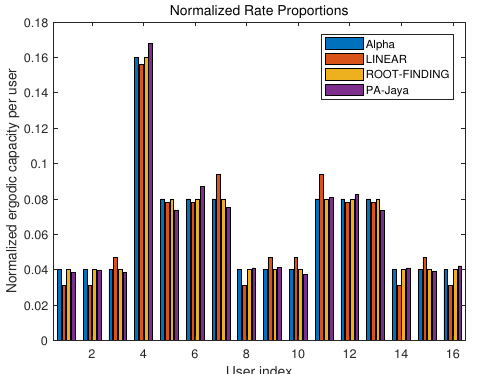
Figure 7. Comparison of different algorithm effects under normalized rate proportional constraint.